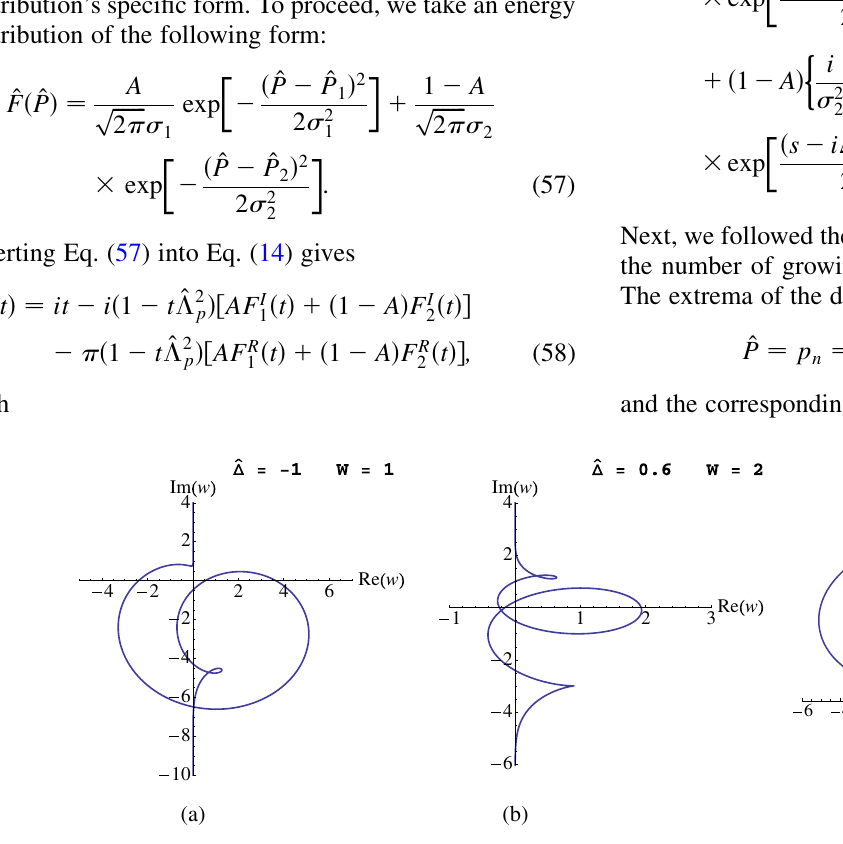
FIG. 6. Contour plots of w ð it Þ as calculated from Eq. (58) for the energy distribution shown in Fig. 7(a). In all three, we used ^(cid:2) p ¼ 1 . (a) The winding number for ^(cid:3) ¼ (cid:3) 1 is W ¼ 1 , and hence, there is one growing root. (b) The winding number for ^(cid:3) ¼ 0 : 6 is W ¼ 2 , and hence, there are two growing roots. (c) The winding number for ^(cid:3) ¼ 4 is W ¼ 0 , and accordingly, there are no growing roots.